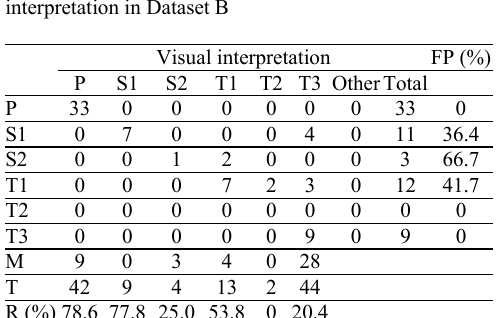
Table 3. The evaluation of Paris road furniture interpretation in Dataset B